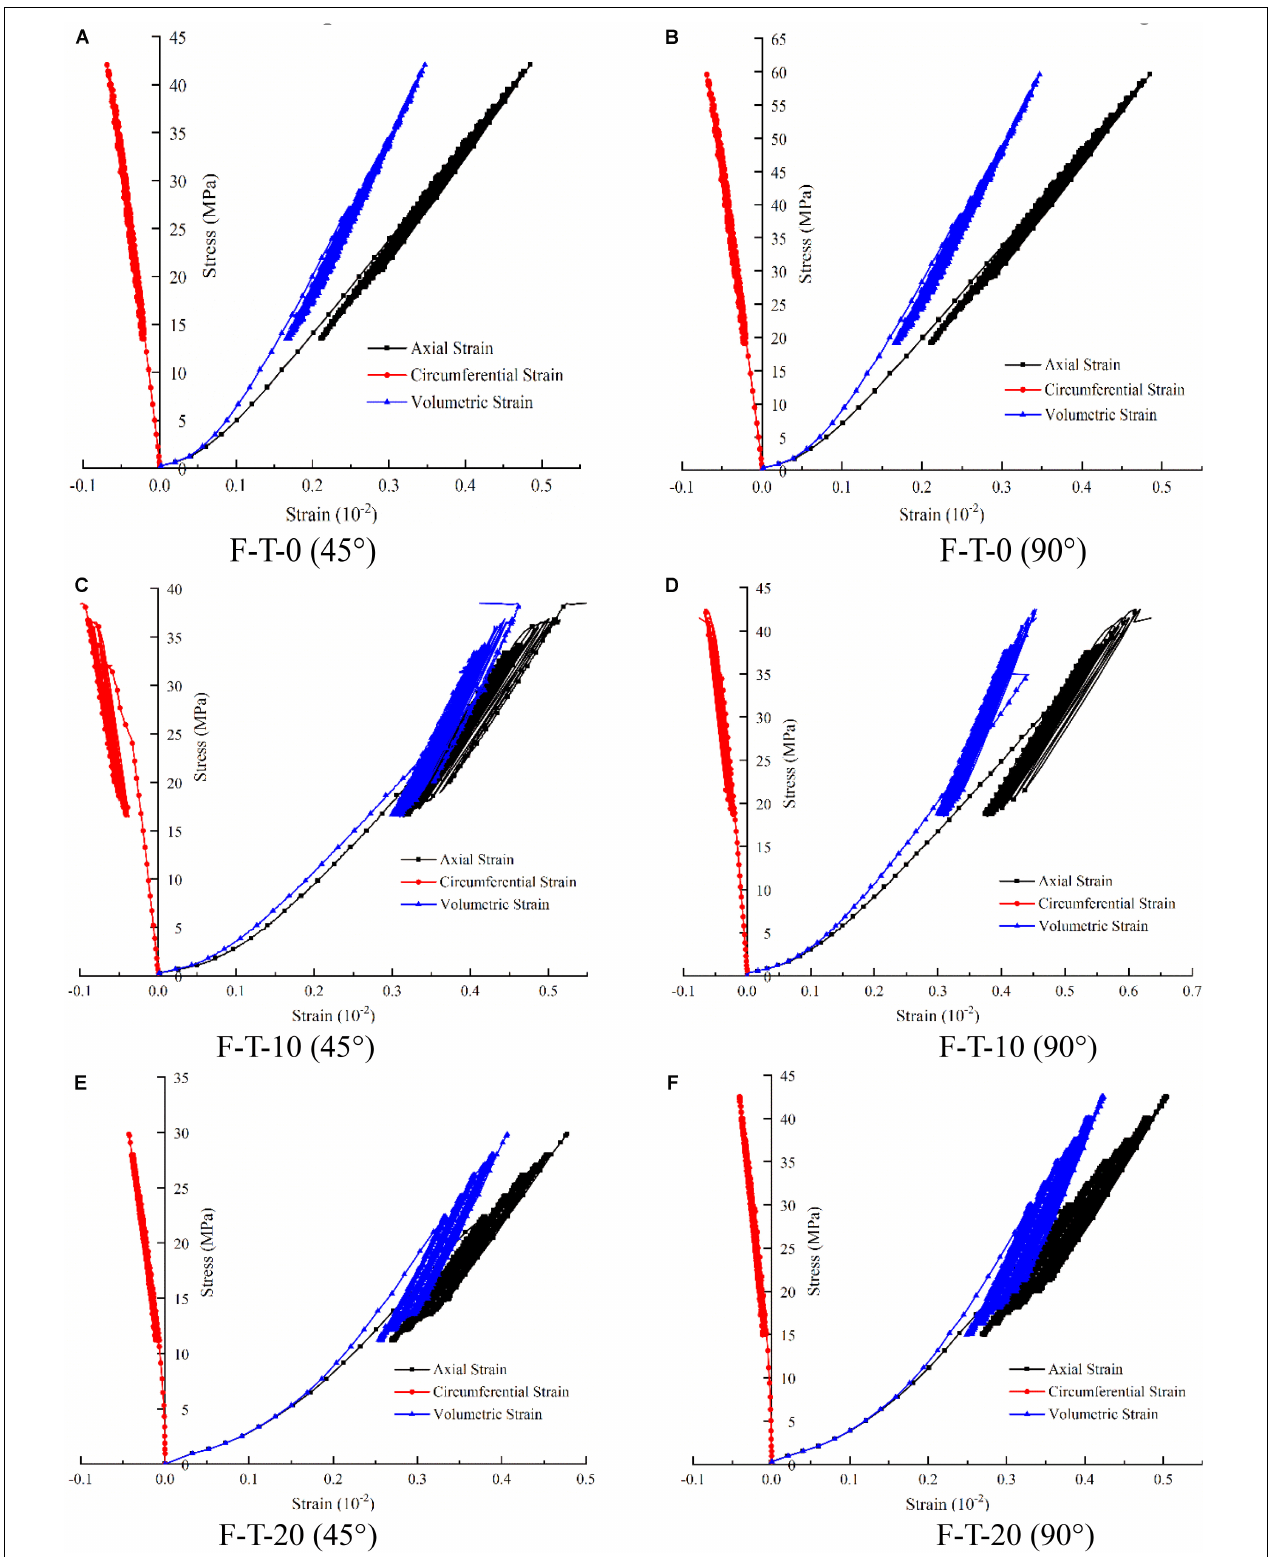
FIGURE 4 | The stress-strain curves of fractured sandstone under different F-T cycles.